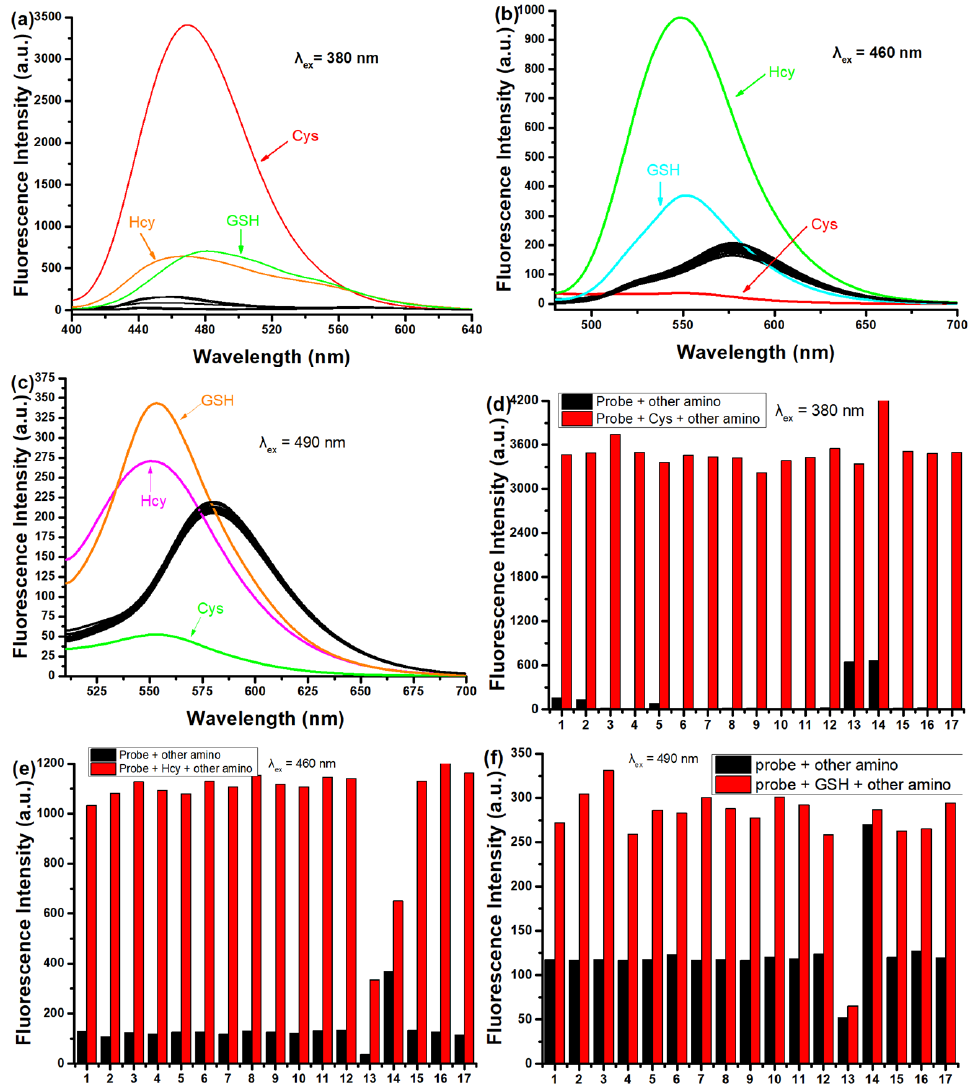
Figure 2. ( a – c ) Fluorescence responses and ( d , e ) competitive responses of SWJT-14 (10.0 µ M) with different analytes in PBS buffer solution (0.5% DMSO, pH 7.40). Analytes: Met, Leu, Pro, Thr, Try, Arg, Glu, Gly, Phe, Ser, Ala, H 2 S, Cys, Hcy, GSH, Lys, His and Et 3 N. ( a , d ) λ em = 470 nm, bars represent the fluorescence responses after the addition of the probe and other analytes. The red bars represent the fluorescent responses to the subsequent addition of ( d ) Cys, ( e ) Hcy or ( f ) GSH to the above